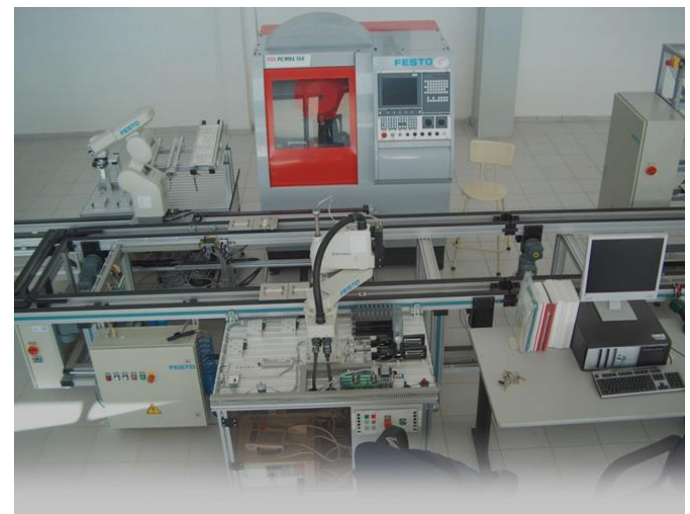
Figure 7. Traditional CPS: iCIM3000 didactic cubicle.